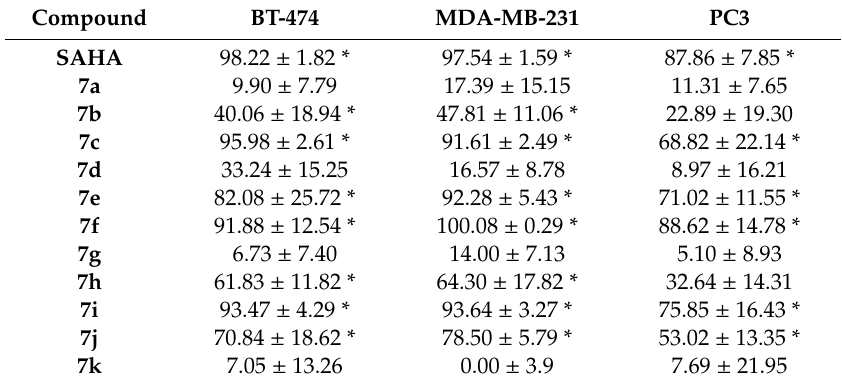
Table 2. Growth inhibitory e ff ects (GI%) exerted by compounds 7a – k on three cancer cell